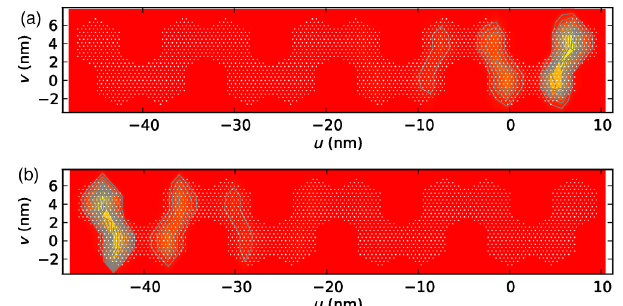
FIG. 5 (color online). 2D plots of the wave functions of the edge states calculated at k ¼ 0 . 3 × 2 π =l for the ribbon considered in Fig. 4(a) (energy of the states equaling approximately − 0 . 123 eV). The plots are restricted to a single unit cell of the ribbon [(a) higher-energy state, (b) lower-energy state]. The vertical axis corresponds to the direction of the ribbon. More than 90% of each wave function is localized on the nanocrystals at the edges. The white dots indicate the atoms.